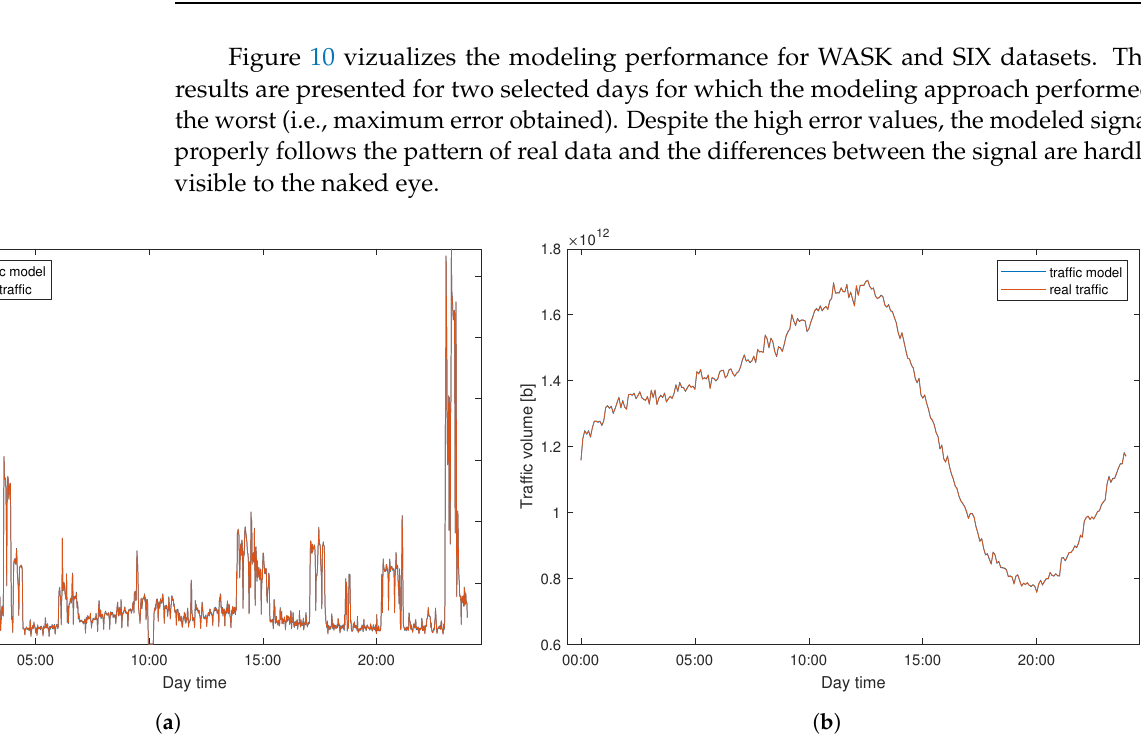
Figure 10. Traffic modeling efficiency—observed and modeled traffic as a time function. ( a ) WASK dataset, 19 January 2021, ( b ) SIX dataset, 26 January